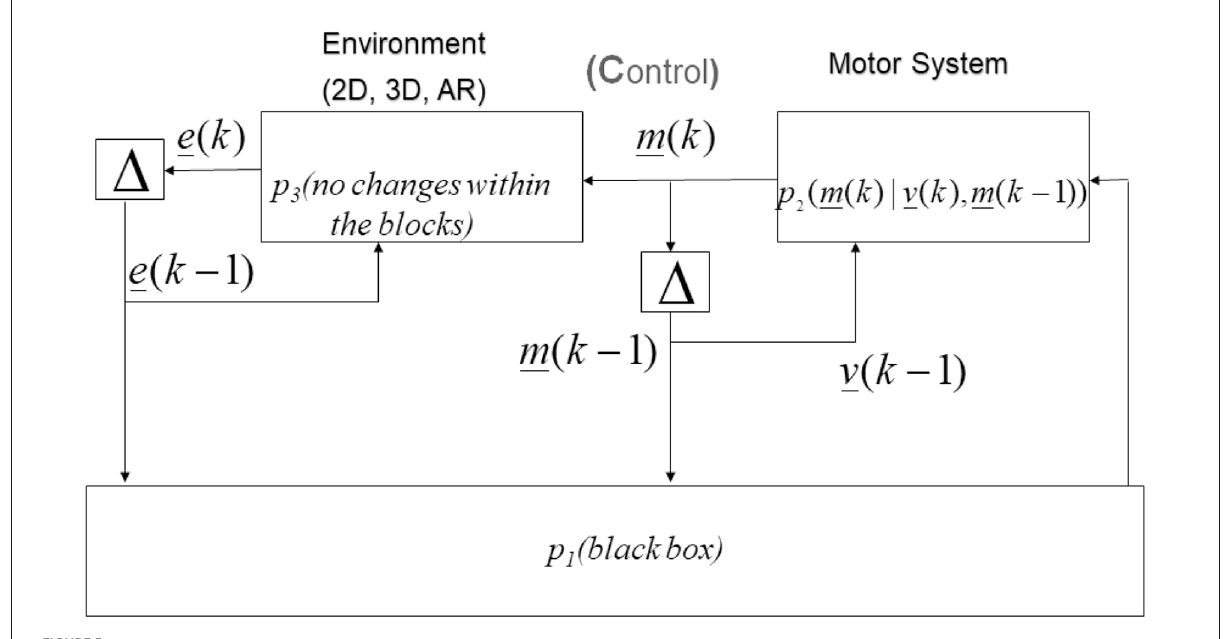
FIGURE5 Hands motor system control driven by the environment in a Markov chain